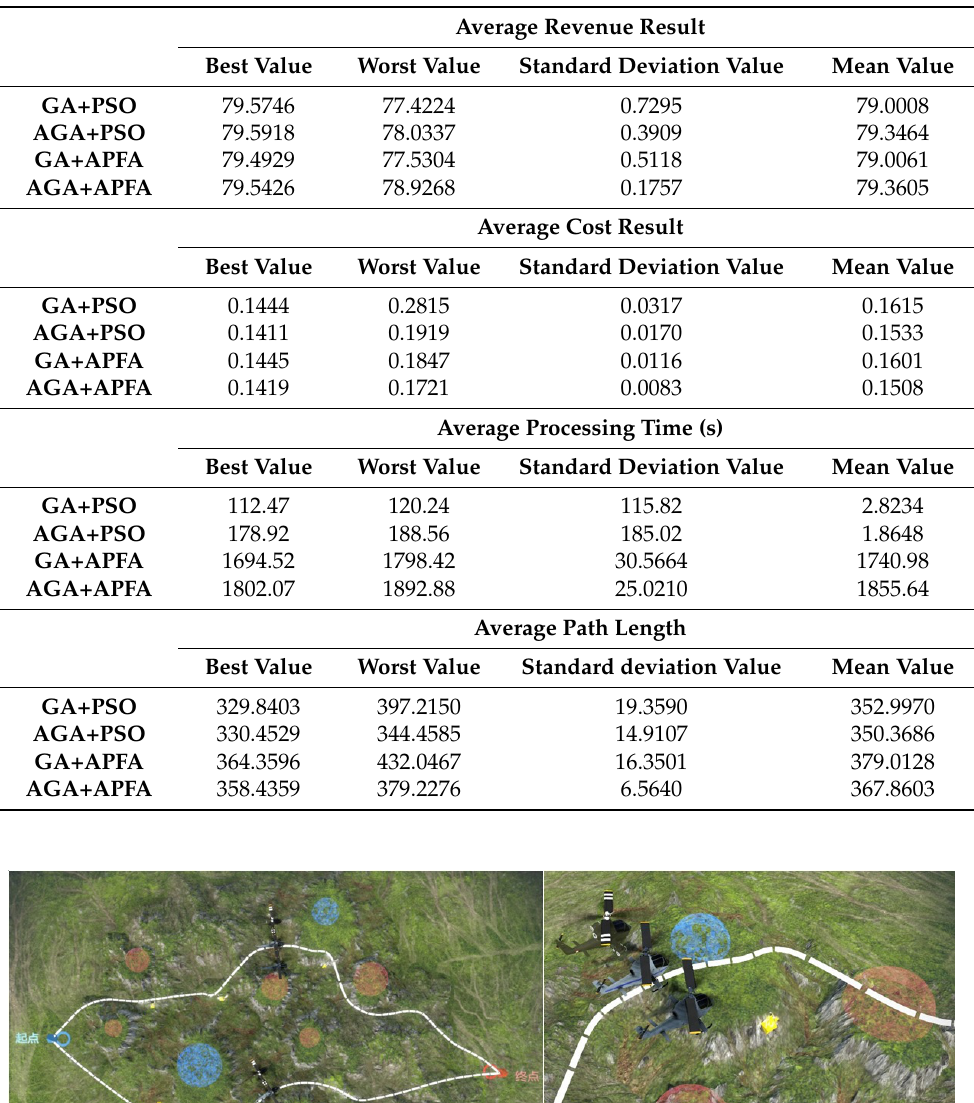
Table 21. Statistical evaluation results of average revenue, average cost, average processing time, and average path length using GA, AGA, PSO, and APFA.